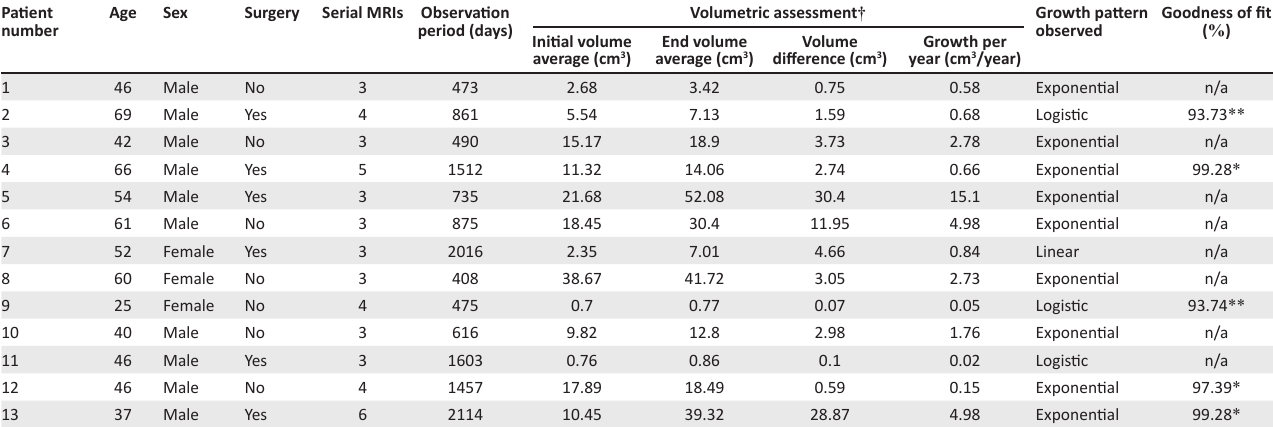
TABLE 1: Clinical data, imaging studies as well as growth patterns observed during the observation period. Patient Age Sex Surgery Serial MRIs Observation number